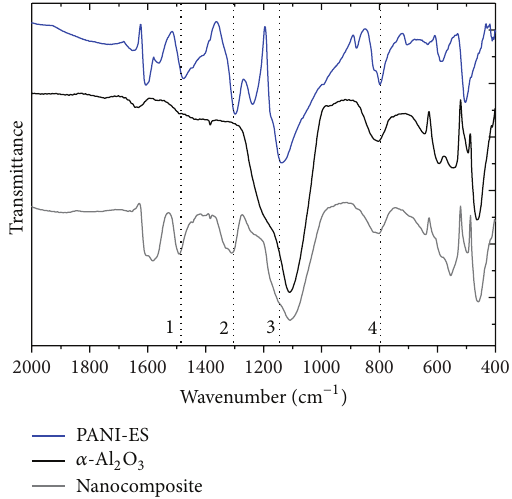
Figure 1: FTIR of PANI-ES, 𝛼 -Al 2 O 3 , and nanocomposite.